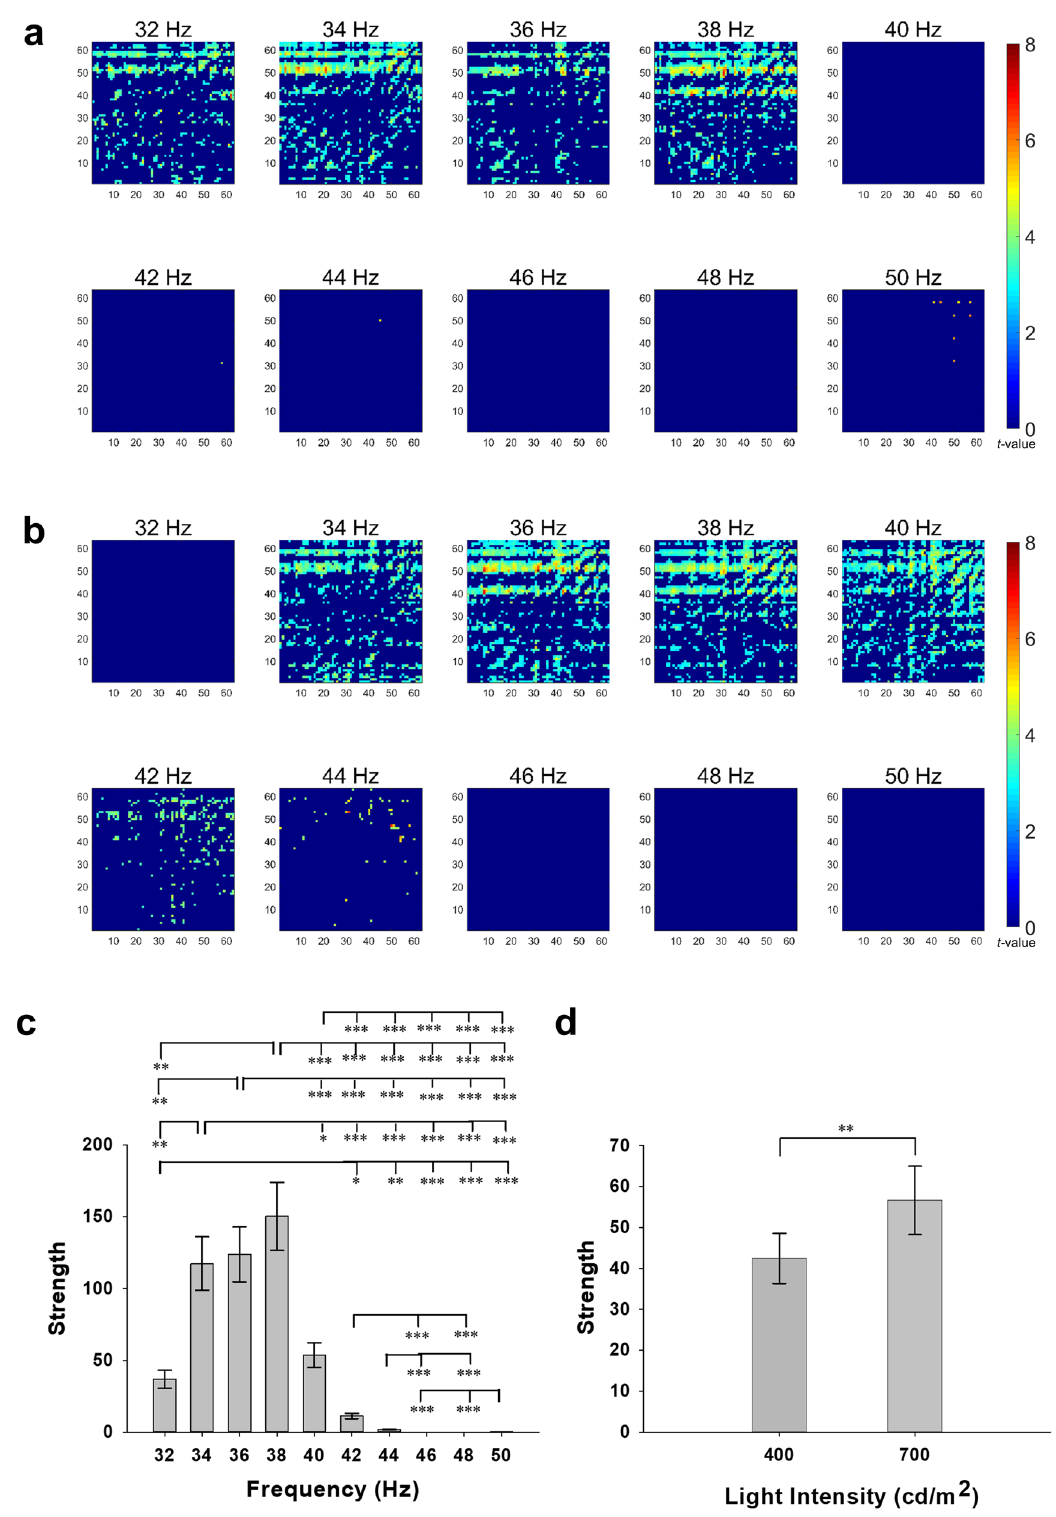
Figure 4. The spectral Granger causality of entrained gamma EEG. Changes in the gamma wave spectral Granger causality of 1953 connections between 63 electroencephalogram (EEG) electrodes induced by flickering light stimulus in the second experiment ( A , B ) and the averaged strength of the occipitoparietal to frontotemporal gamma wave connections estimated using spectral Granger causality analysis ( C , D ). ( A ) 400 cd/m 2 and ( B ) 700 cd/m 2 . The left-upper side of each matrix represents the occipitoparietal to frontotemporal connections. The numbers of EEG electrodes from 1 to 63 correspond to Fp1, Fp2, AF7, AF3, AFz, AF4, AF8, F7, F5, F3, F1, Fz, F2, F4, F6, F8, FT9, FT7, FC5, FC3, FC1, FC2, FC4, FC6, FT8, FT10, T7, C5, C3, C1, Cz, C2, C4, C6, T8, TP9, TP7, CP5, CP3, CP1, CPz, CP2, CP4, CP6, TP8, TP10, P7, P5, P3, P1, P2, P4, P6, P8, PO7, PO3, POz, PO4, PO8, O1, Oz, and O2, respectively. Error bars indicate standard errors. * p < 0.05, ** p < 0.01, *** p <